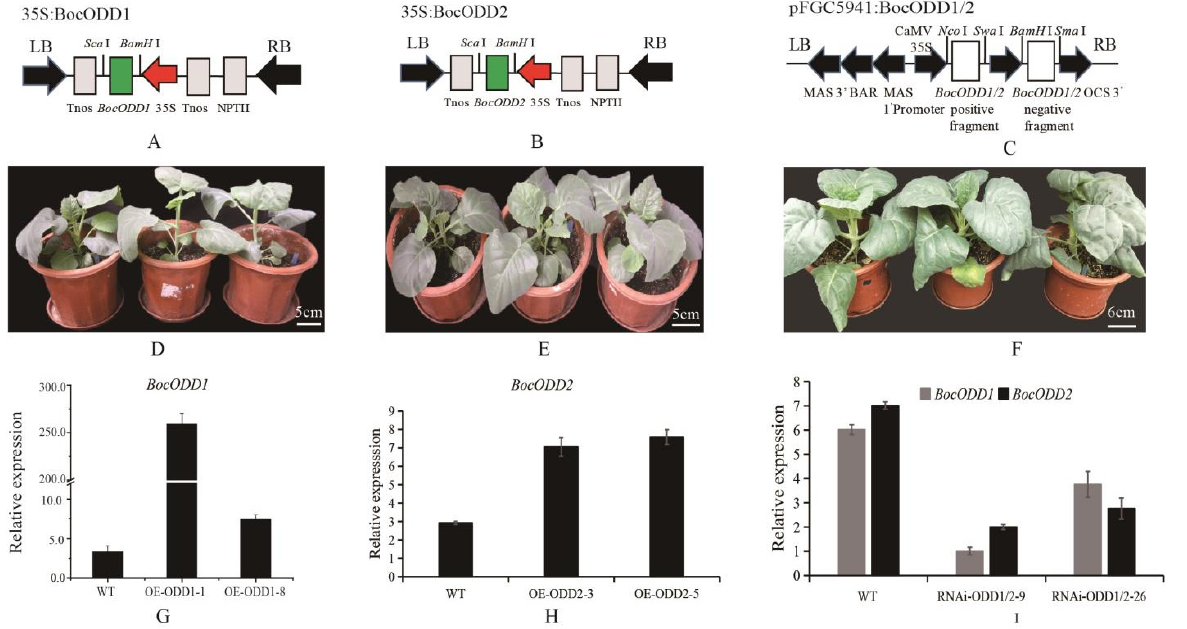
Figure 7. Functional analysis of BocODD1/2 . ( A ) The structure of overexpression vector for BocODD1 ; ( B ) the structure of overexpression vector for BocODD2 ; ( C ) the structure of RNAi vector for BocODD1/2 ; ( D – F ) the phenotypes of overexpression and RNAi transgene plants; ( G ) and ( H ) the expression levels of BocODD1 or BocODD2 in overexpression plants, respectively; ( I ) the expression levels of BocODD1 or BocODD2 in RNAi plants. Table 1. The content of glucosinolates of BocODD1/2 transformed plants.